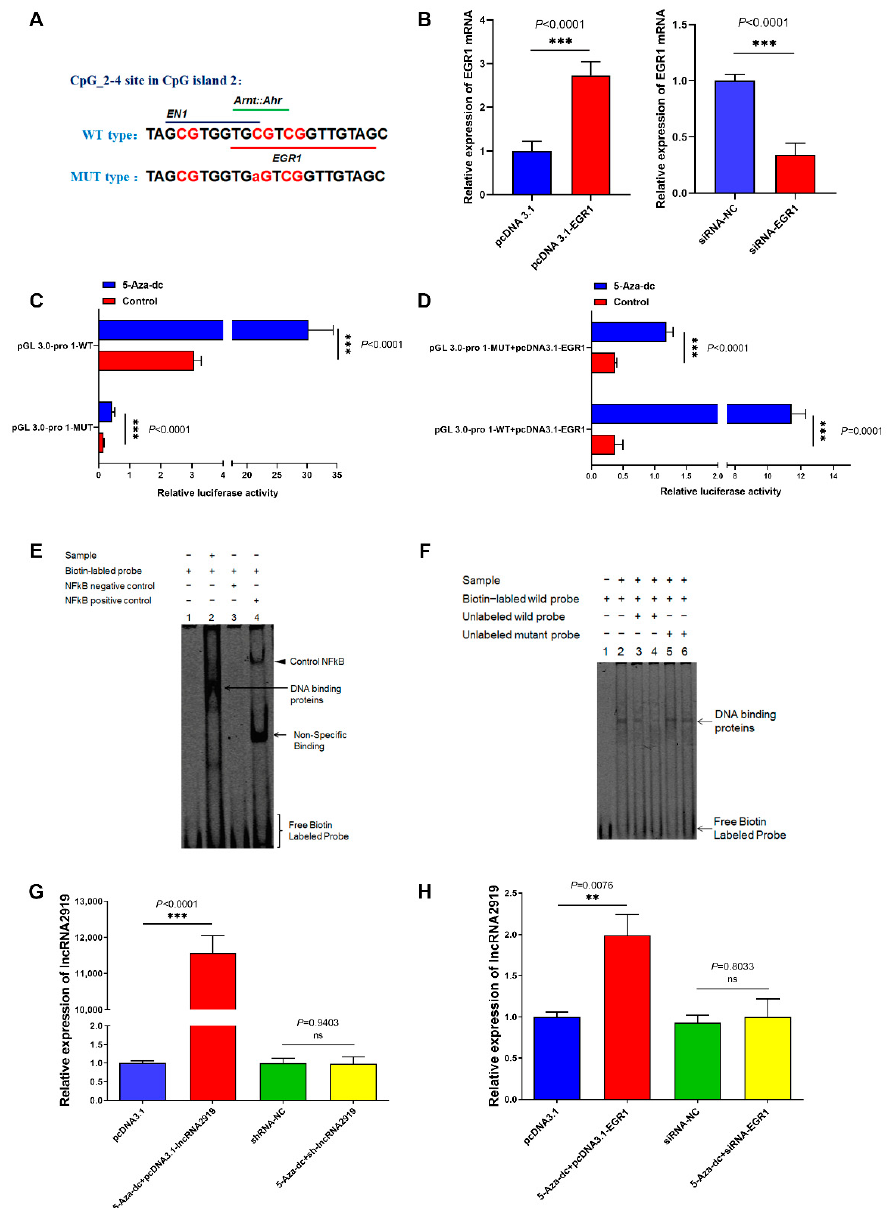
Figure 5. TF EGR1 regulates the transcriptional expression of lncRNA2919. ( A ) The TF prediction of CpG_2 to CpG_4 in CpG island 2 of the lncRNA2919 promoter region. ( B ) The EGR1 mRNA expression level after EGR1 overexpression and knockdown in DPCs. ( C ) Luciferase activities were detected after the transfection of the wild-type and mutant-type vectors of EGR1 after demethy- lation. ( D ) Luciferase activities were detected after co-transfections of the wild-type vector and EGR1, and the mutant-type vector and pcDNA3.1-EGR1 after demethylation. ( E ) The binding rela- tionship between EGR1 and the lncRNA2919 promoter was verified through EMSA. ( F ) The binding relationship between EGR1 and the lncRNA2919 promoter was verified through competitive EMSA.